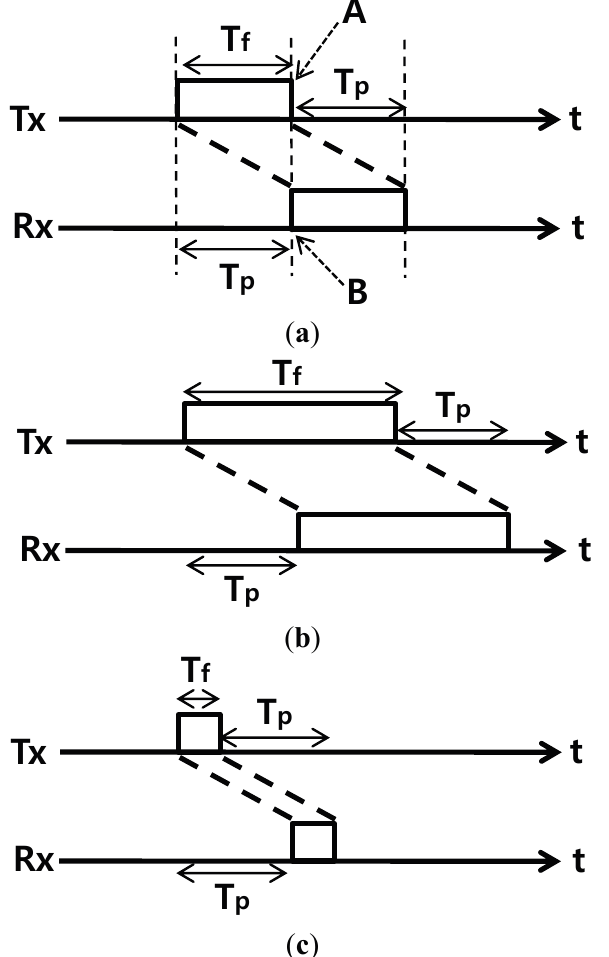
Figure 2. Frame timing between transmitting/receiving nodes. ( a ) T f = T p ; ( b ) T f > T p ; ( c ) T f < T p